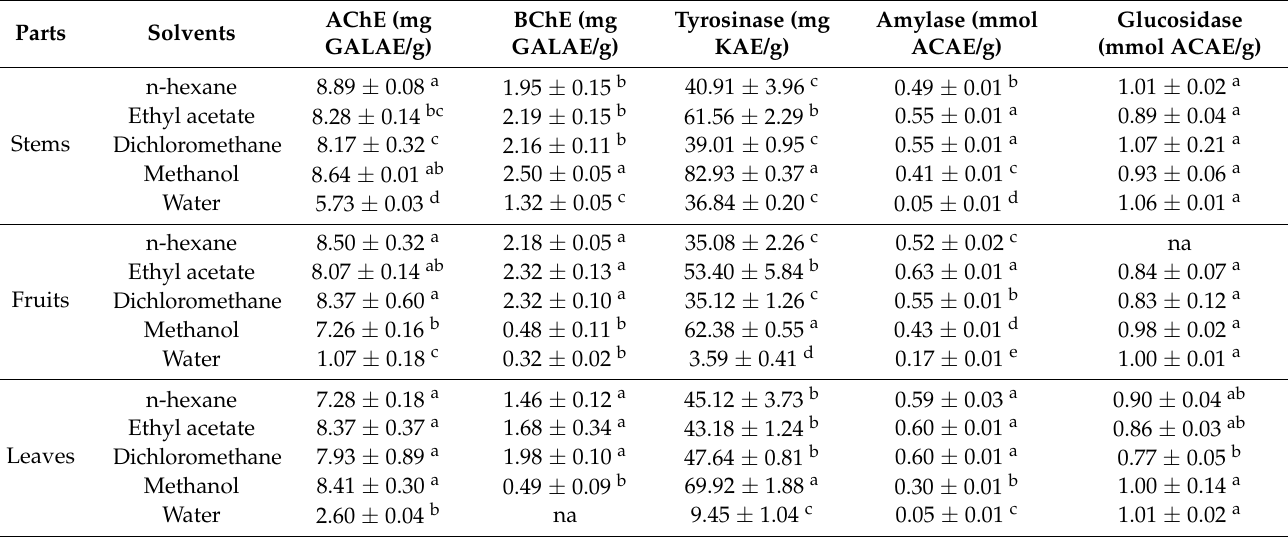
Table 3. Enzyme inhibitory properties of the tested